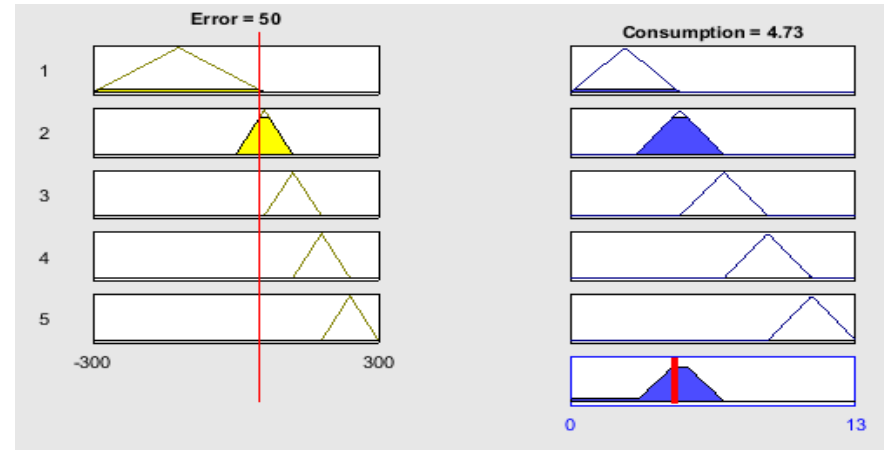
Figure 14. Applied rule for a single value based on the air quality fuzzy controller.